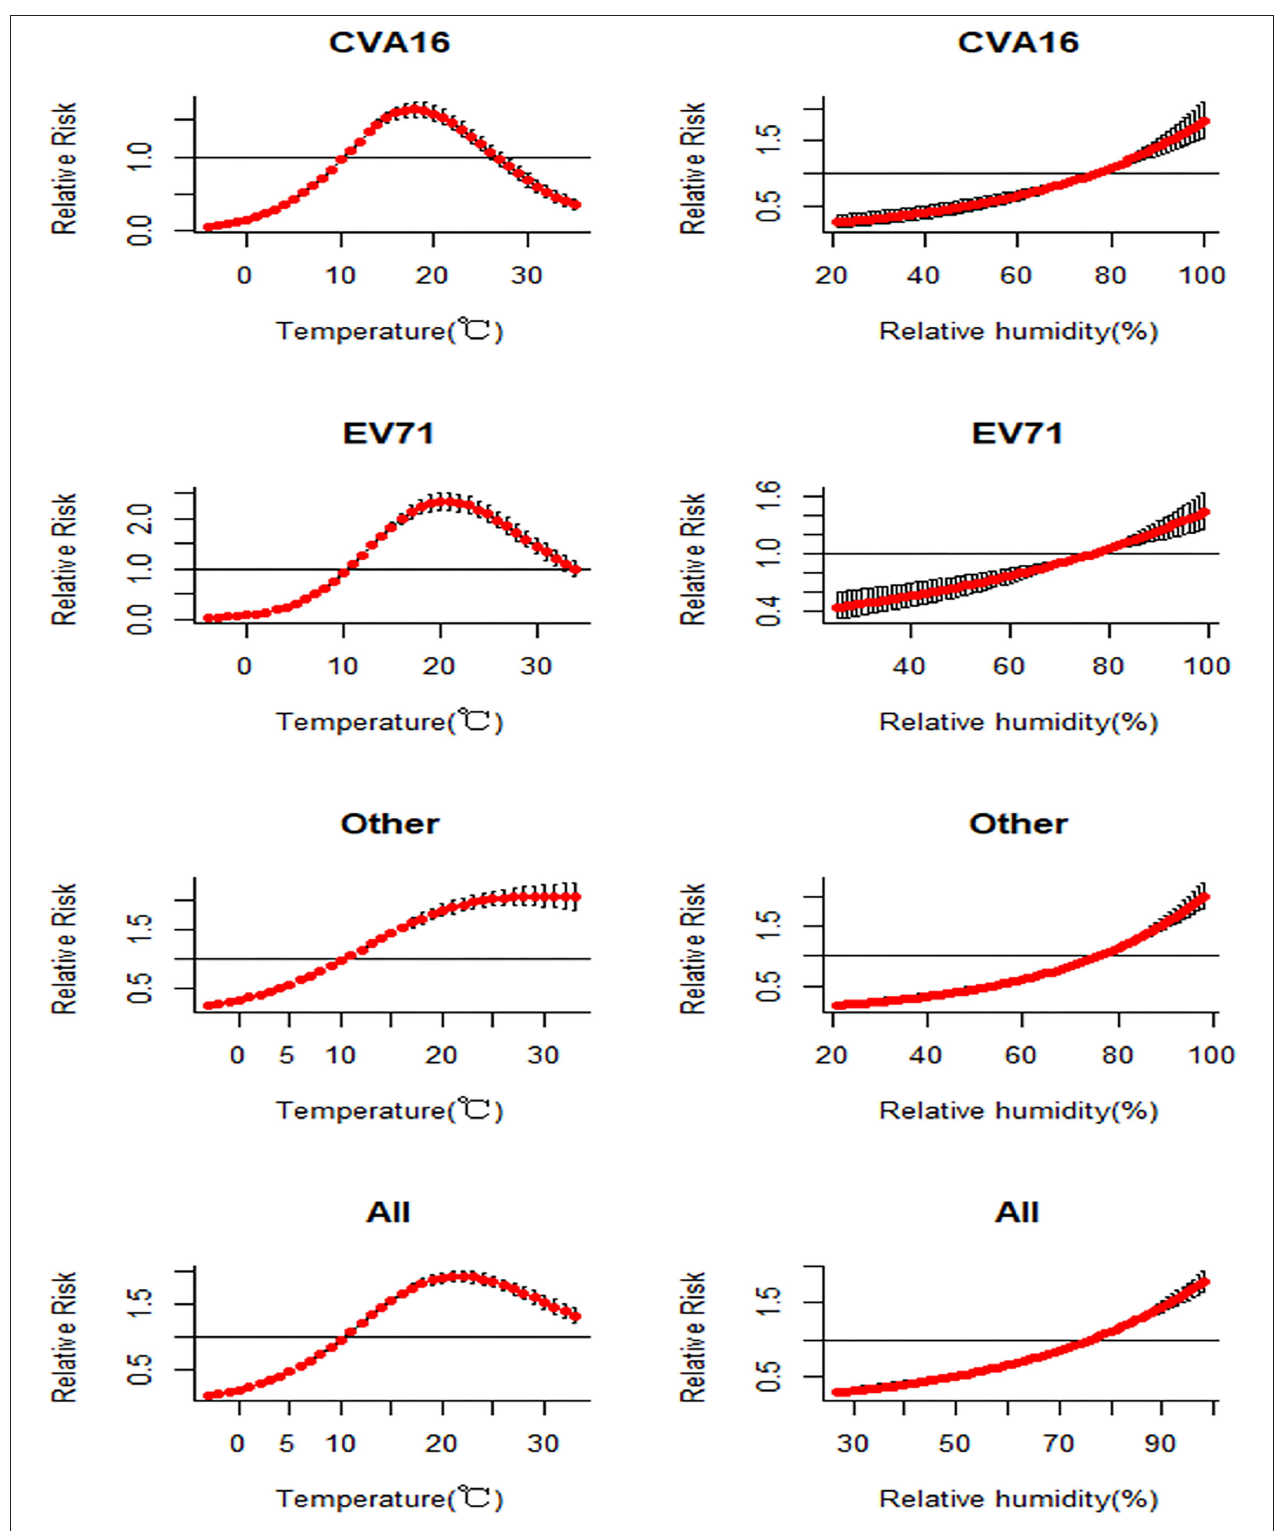
FIGURE 5 | Associations between incidence of HFMD and meteorological factors estimated using a case-crossover design by serotype.